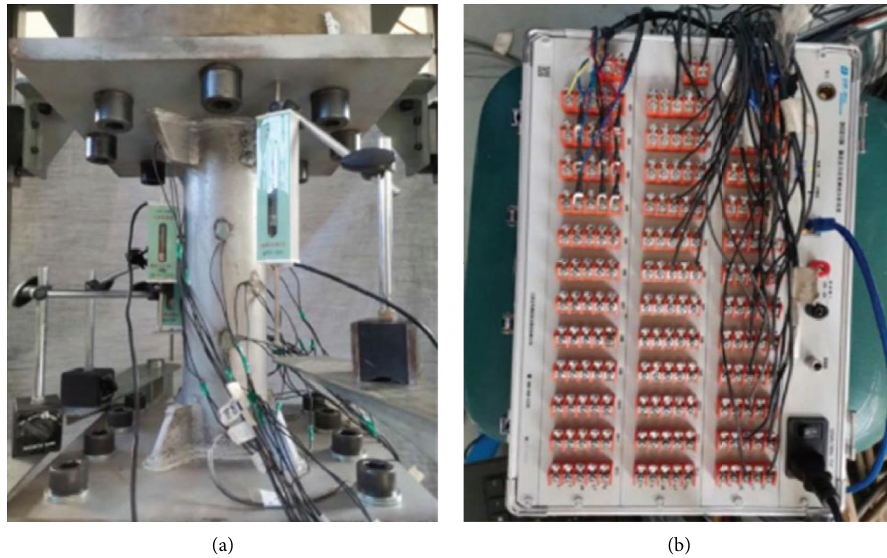
Figure 8: Displacement meter layout and data acquisition device: (a) displacement gauge layout drawing and (b) data acquisition